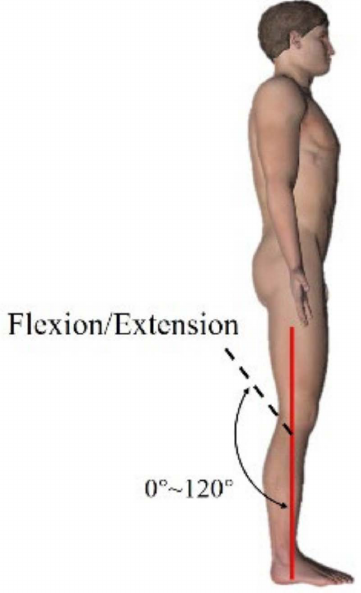
Figure 8. Transient rotation center trajectory of knee joint.